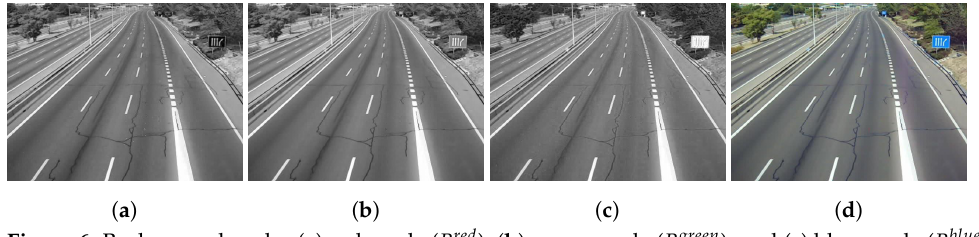
Figure 6. Background under ( a ) red mode ( B red ), ( b ) green mode ( B green ), and ( c ) blue mode ( B blue ) and ( d ) the reconstructed RGB-mode background ( B RGB ) .